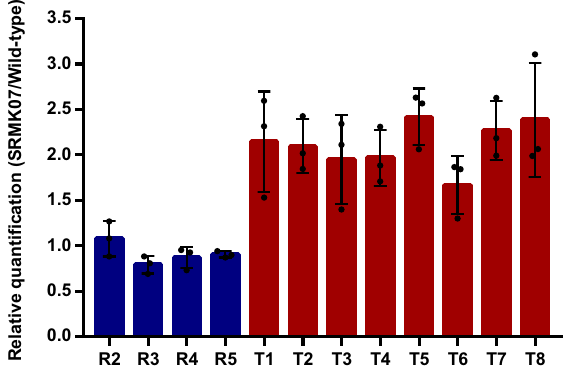
Figure 3. Relative quantification of genes from the potentially duplicated region in the SRMK07 strain’s genome. For this, five reference single-copy genes (‘R1’ to ‘R5’ defined below) and eight genes (‘T1’ to ‘T8’ defined below) from the potentially duplicated region in the SRMK07 strain’s genome were first selected for the qPCR experiments. A gene ‘R1’ encoding NADH-quinone oxidoreductase subunit H (5,392,720 – 5,393,685 bp in the NRRL 5491 genome) was used as a control to measure the relative quantity of the other four single- copy genes (blue bars), and the eight genes from the potentially duplicated region (red bars). Genes ‘R2’, ‘R3’, ‘R4’, and ‘R5’ are those known to exist as a single copy across Streptomyces species, and encode the following proteins, respectively (along with the chromosome location in the NRRL 5491 genome): RtcB family protein (5,488,049–5,488,159 bp); RNA helicase (5,756,656–5,760,582 bp); aspartate kinase (6,341,319–6,342,599 bp); and type I DNA topoisomerase (6,399,363–6,402,227 bp). Genes ‘T1’, ‘T2’, ‘T3’, ‘T4’, ‘T5’, ‘T6’, ‘T7’, and ‘T8’ from the potentially duplicated region encode the following proteins, respectively: 3-ketoacyl-CoA thiolase (9,778,772–9,809,242 bp); regulatory protein AfsR (9,875,692–9,877,524 bp); l-lysine cyclodeaminase (9,900,735–9,901,766 bp); ferredoxin (9,904,048–9,904,284 bp); glycerol uptake operon antiterminator regulatory protein (10,001,392–10,002,039 bp); hypothetical protein (10,003,629–10,004,255 bp); SDR family oxidoreductase (10,035,843–10,036,631 bp); and putative ABC transporter ATP-binding protein YbiT (10,693,310–10,694,929 bp). ‘T1’ and ‘T8’ represent the start and end regions of the potentially duplicated region. ‘T3’, ‘T4’ and ‘T6’ belong to rapamycin BGC. The primers used for these qPCR experiments are available in Supplementary Table S2. The presented data represent the mean from triplicate experiments, and the error bars indicate standard